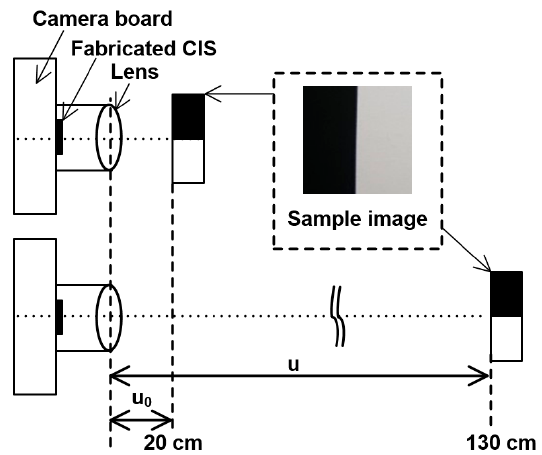
Figure 10. Measurement setup for evaluation of disparity information.